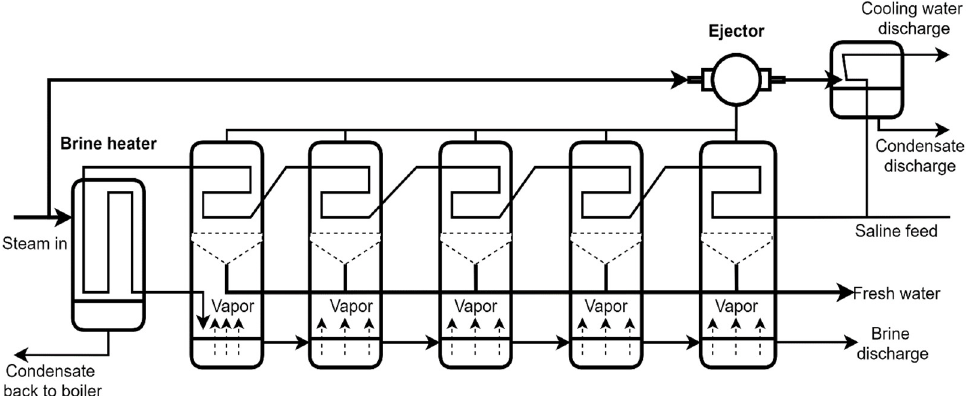
Figure 3. Schematic diagram of MSF, amended from [34].